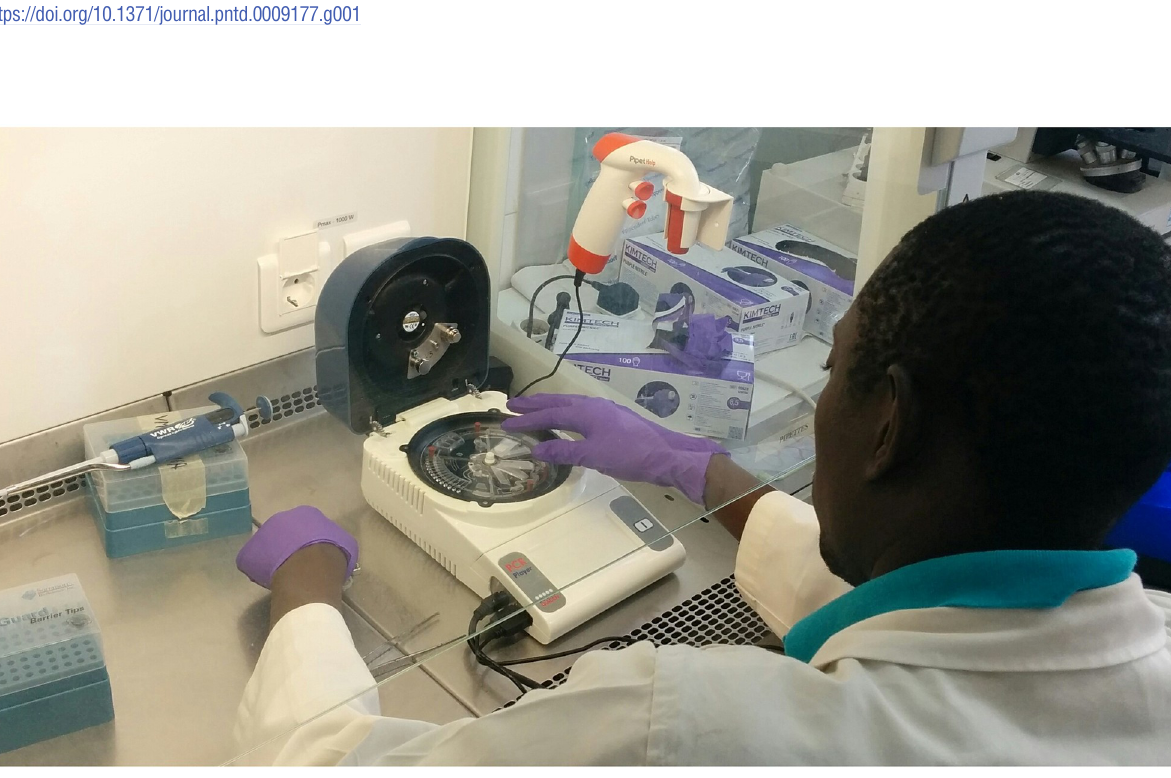
PLOS NeglectedTropical Diseases | https://doi.org/10.1371/journal.pntd.0009177 February 25, 2021 7 /